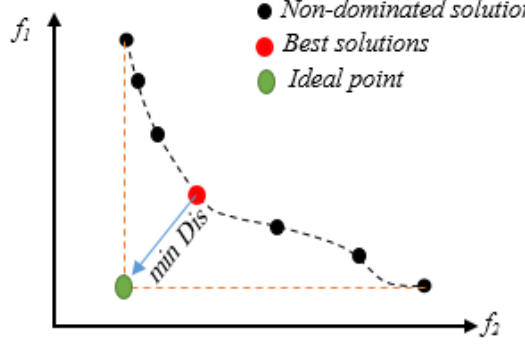
Fig. 3. Selecting the best solution by decision-making